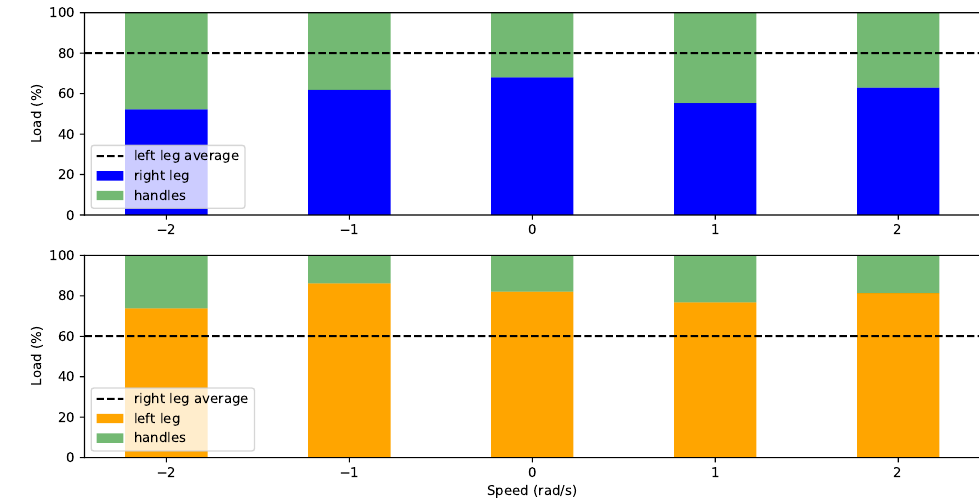
Figure 12. Weight bearing on support leg for user 2 by steering